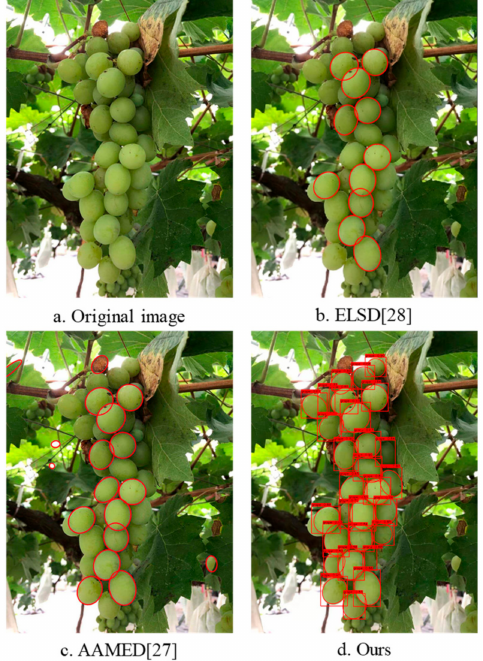
Figure 12. Test results of three fitting algorithms.